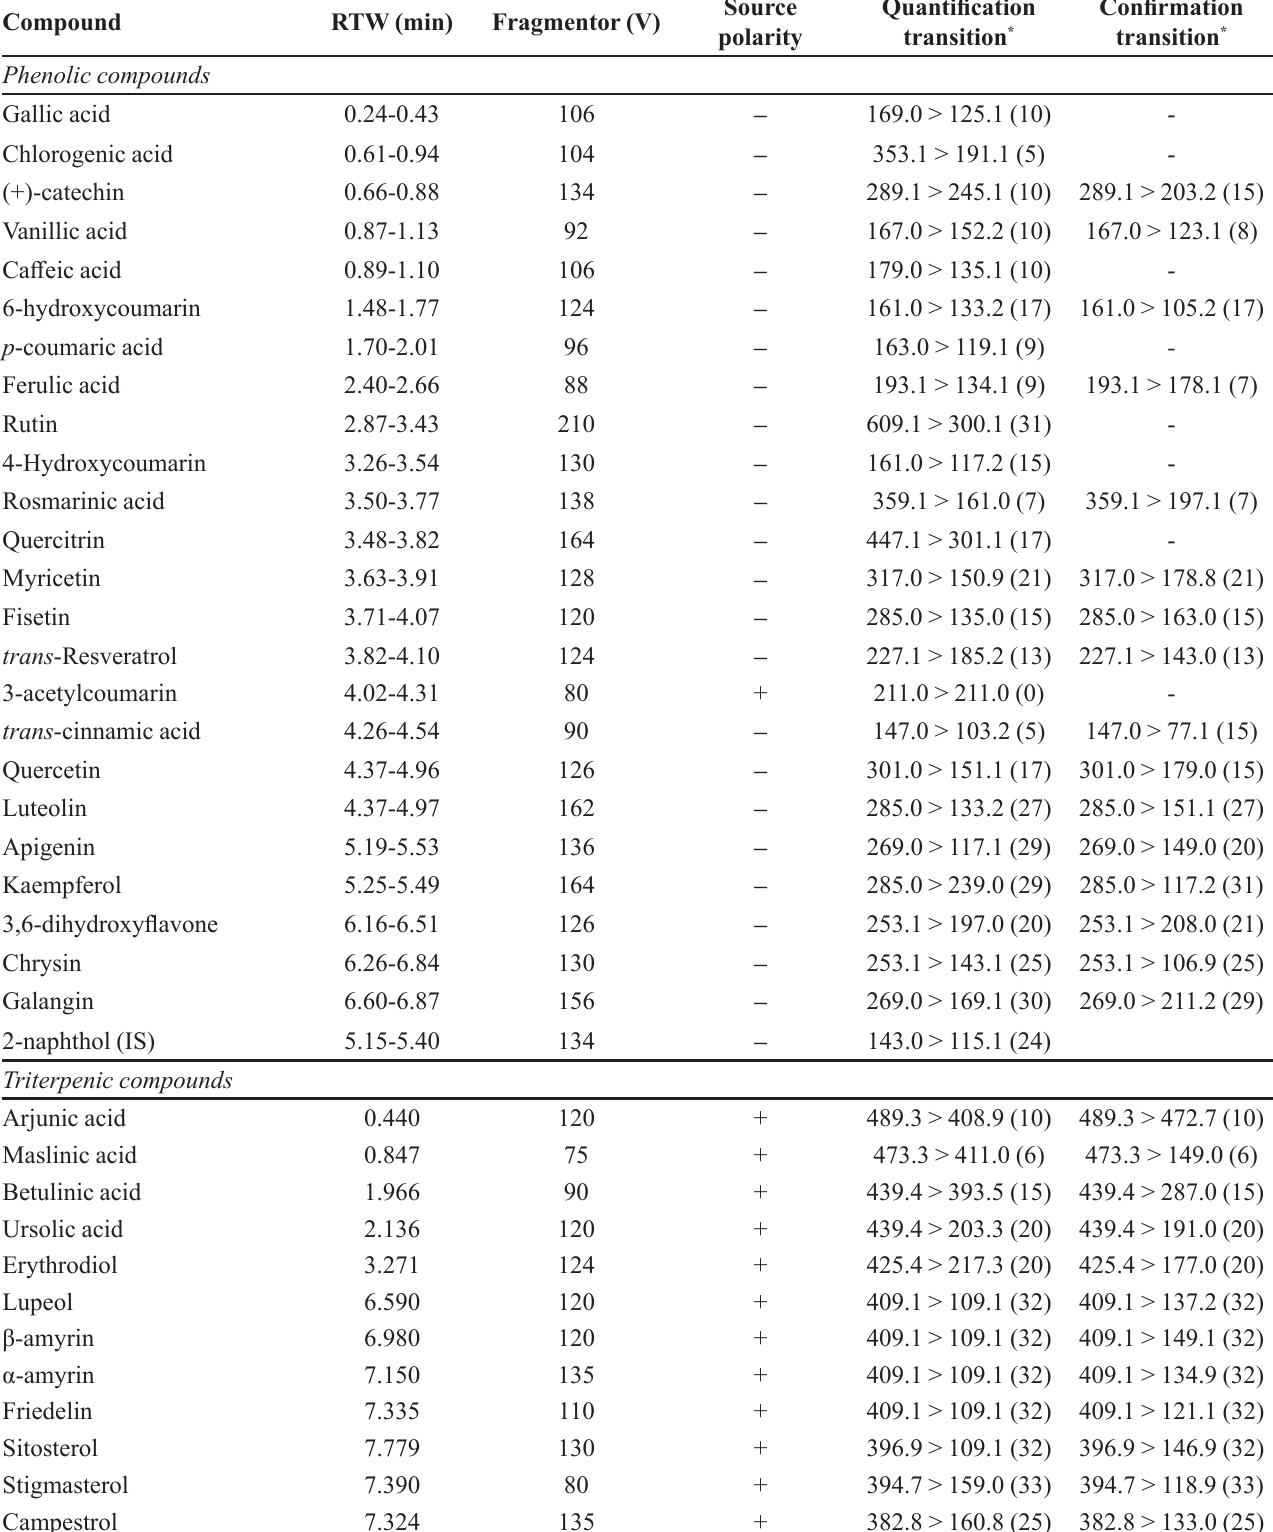
TABLE II - Retention time windows (RTW) and MS/MS parameters of the phenolic and triterpenic compounds